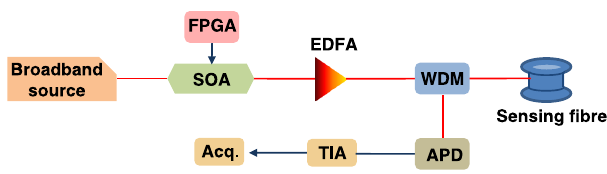
Fig. 7 Experimental setup for GO-code and single-pulse ROTDR.